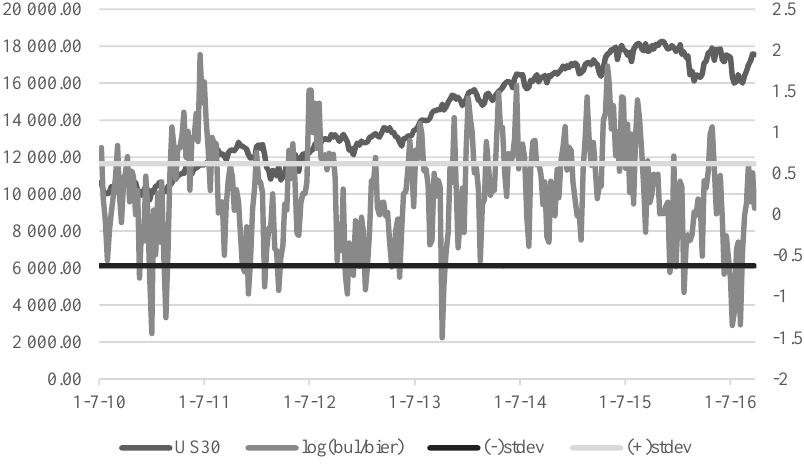
Figure 5. Dynamic of historical data for individual investors’ sentiments (AAII) and the US30